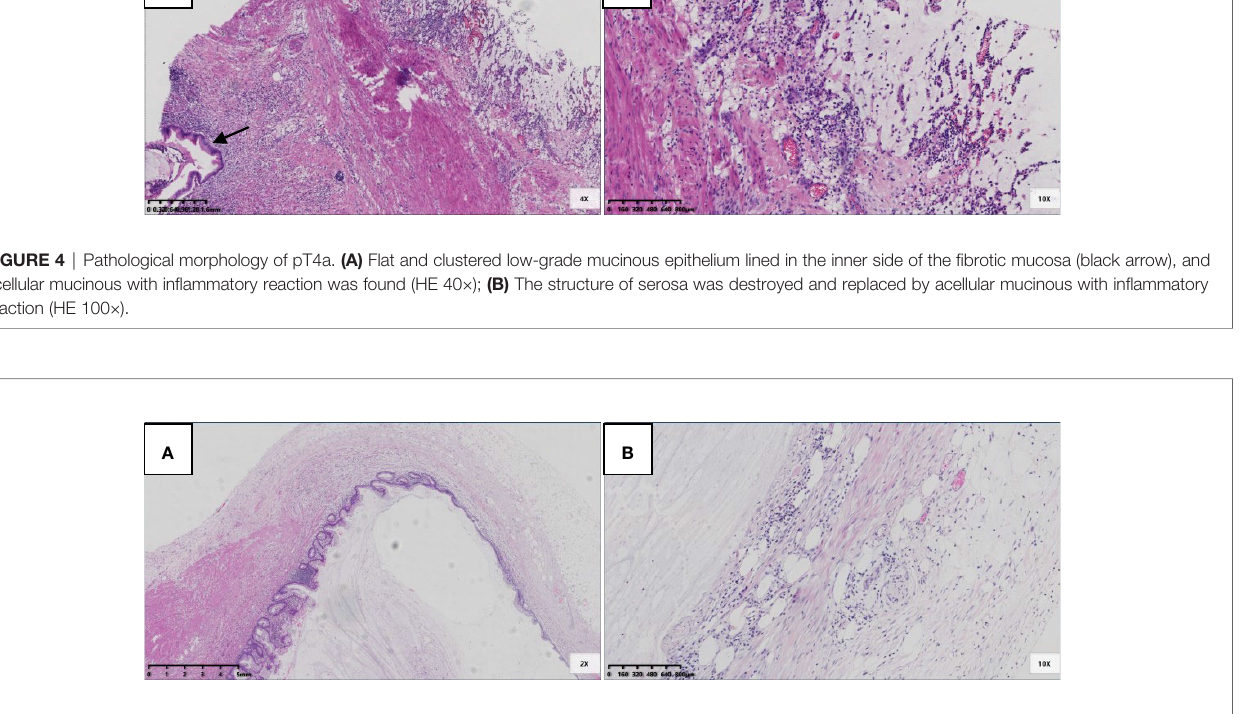
FIGURE 5 | pT3 with diverticulum. (A) Rupture of muscularis propria (black arrow), mucous epithelium, and mucus diverticulate along the rupture (blue arrow) (HE 20×); (B) In the part of diverticulum, acellular mucinous was directly located in the mesoappendix (HE 100×).